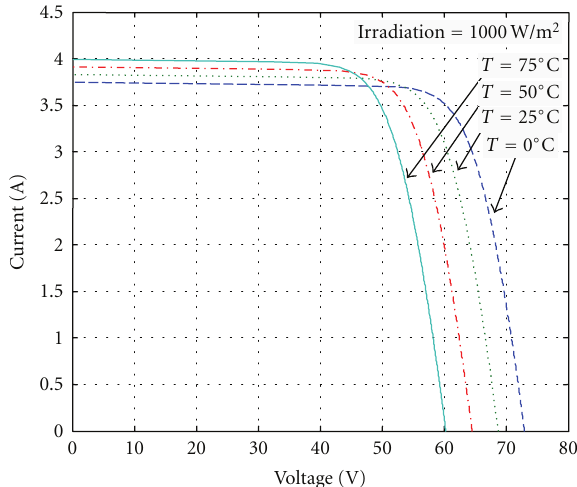
Figure 11: E ff ects of temperature at constant solar radiation on the PV module.